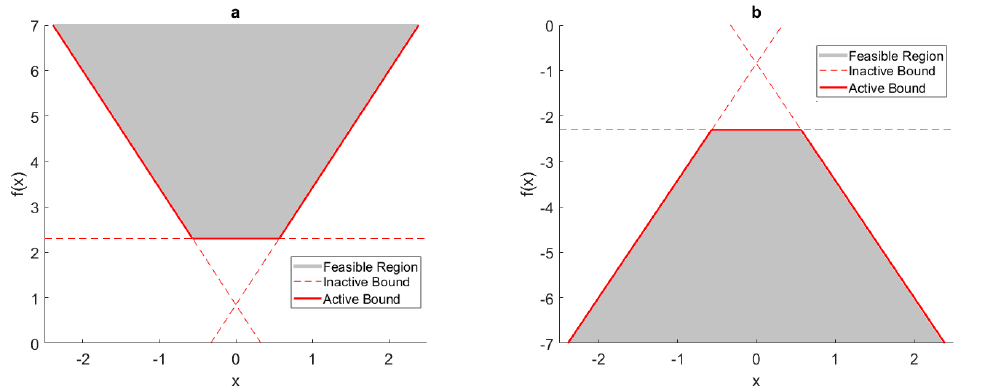
Figure 14. ( a ) Convex feasible region produced by bounding a parameter to be greater than a set of convex line segments. ( b ) Concave feasible region produced by bounding a parameter to be less than a set of concave line segments.